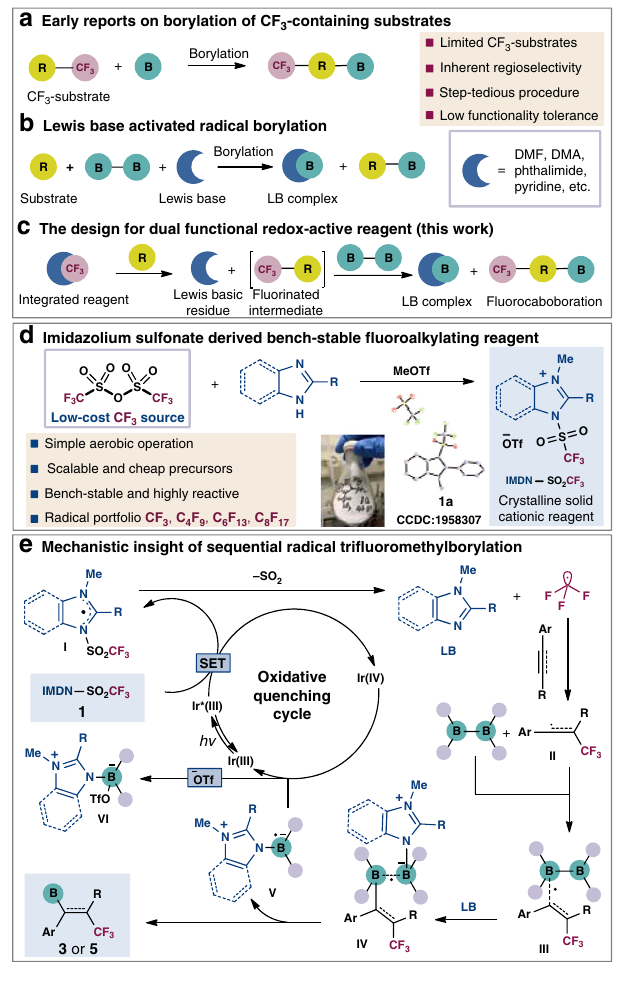
Fig. 1 Origin of the reaction design. a Early reports on borylation of CF 3 - containing substrates. b Lewis base-activated radical borylation. c The design for dual functional redox-active reagent. d Imidazolium sulfonate- derived bench-stable fl uoroalkylating reagent. e Mechanistic insight of sequential radical tri fl